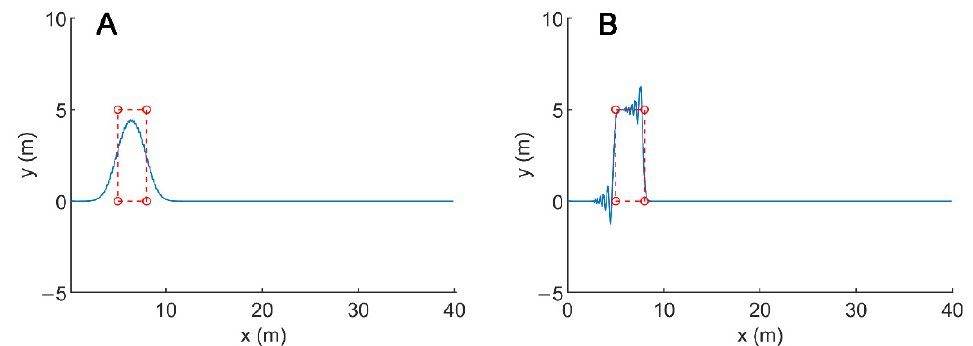
Figure 4. Rockfall simulations using RA: ( A ) in ArcGIS 9.x and ( B ) in ArcGIS 10.x.